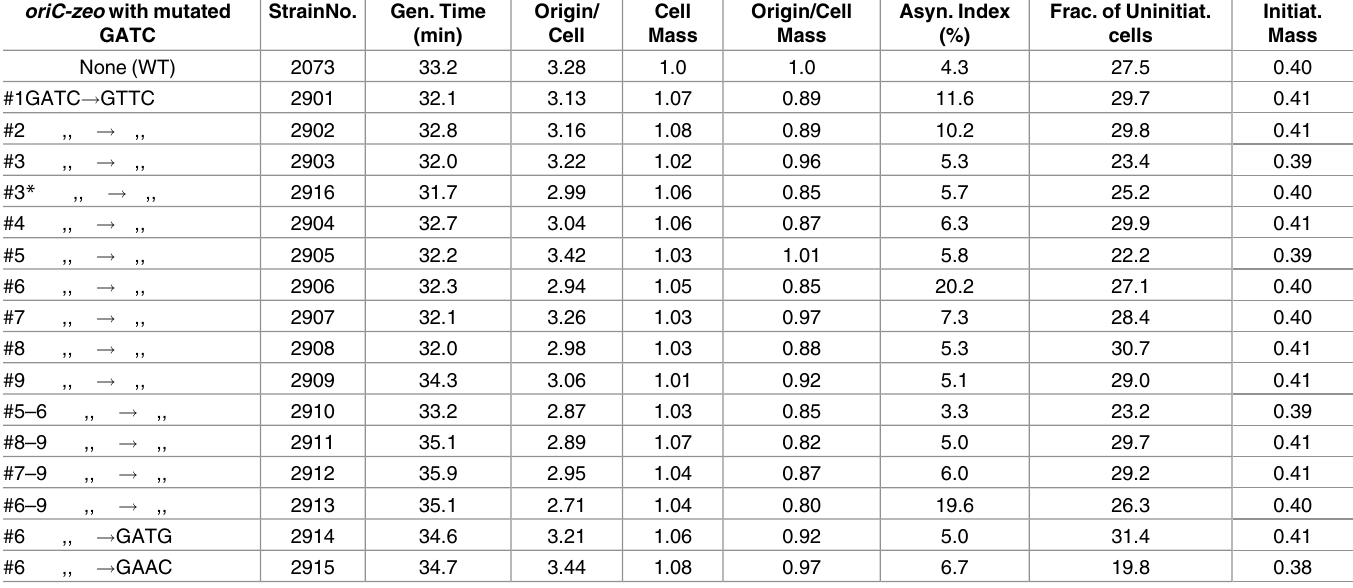
During rapid growth when E . coli maintains multiple origins, sequestration of newly replicated origins is required for synchronous initiation from all the origins in a narrow window of time. Sequestration is mediated by binding of SeqA protein to GATC sites of the origin ( oriC ) when they are hemi-methylated (HM), as in newly replicated origins. To understand the process of Table 2. Cell cycle parameters of oriC - zeo mutants with mutated GATC a oriC-zeo with mutated StrainNo. Gen. Time Origin/ Cell Origin/Cell Asyn. Index Frac. of Uninitiat. Initiat. GATC (min) Cell Mass Mass (%) cells